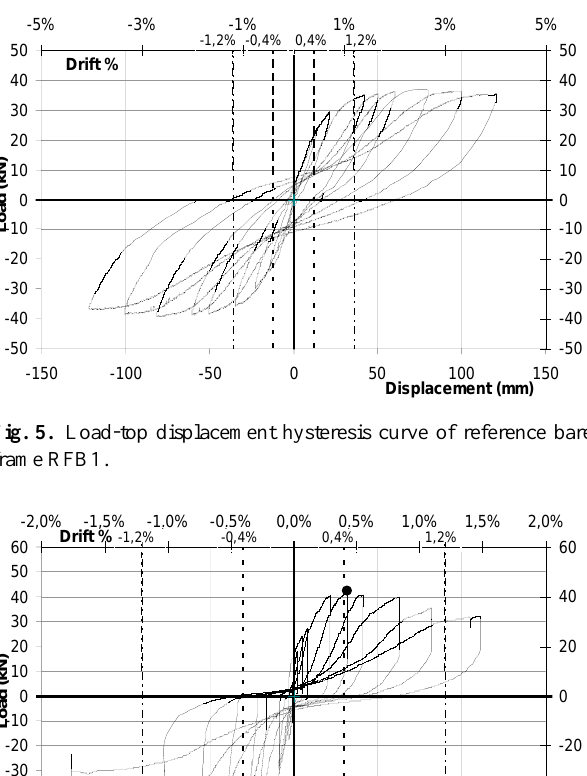
Figure 5 Load-top displacement hysteresis curve of reference bare frame RFB1